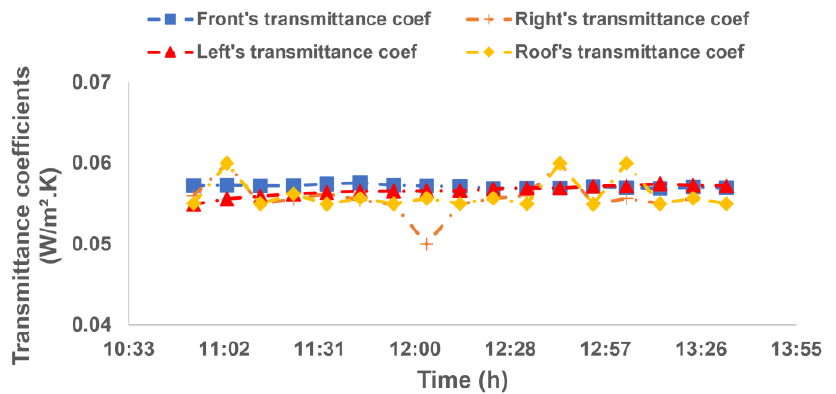
Figure 17. Experimental Transmittance coefficients.